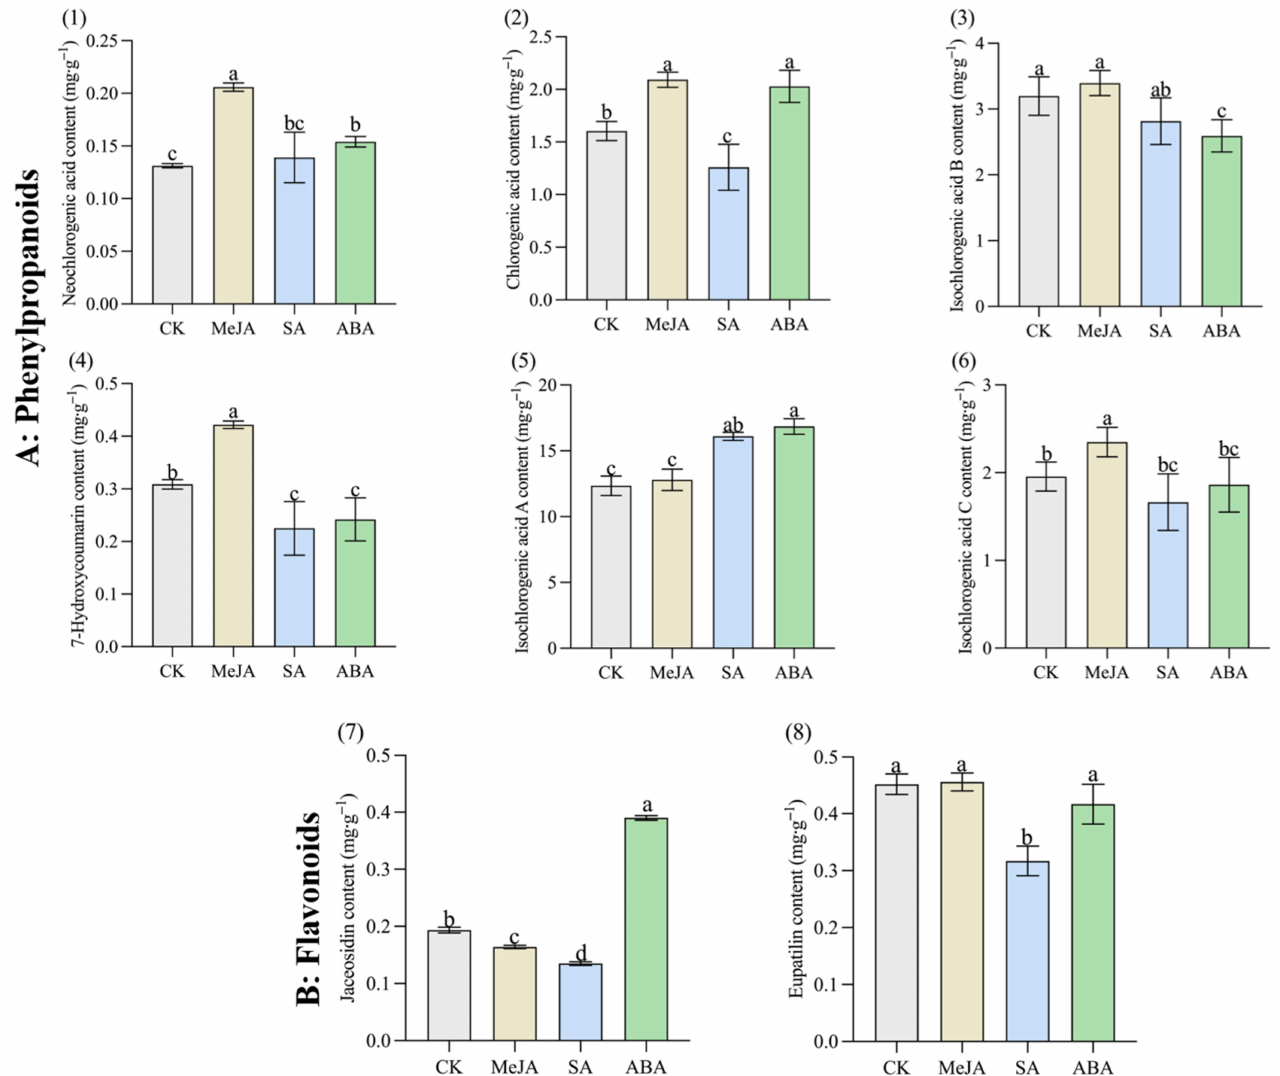
Figure 4. Changes in the content of eight bioactive compounds (six phenylpropanoids and two flavonoids) of A. argyi leaves under the CK, MeJA, SA and ABA treatments. ( 1 ) Neochlorogenic acid; ( 2 ) chlorogenic acid; ( 3 ) isochlorogenic acid B; ( 4 ) 7-hydroxycoumarin; ( 5 ) isochlorogenic acid A; ( 6 ) isochlorogenic acid C; ( 7 ) jaceosidin; ( 8 ) eupatilin. The data are expressed as the means ± standard deviations (SDs, n = 3). The different lowercase letters indicate significant differences between treatments ( p < 0.05) by Duncan’s single-factor variance